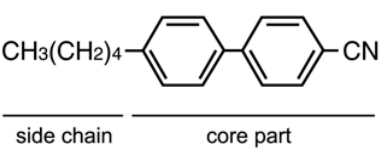
Figure 1. An illustration of the structure of 5CB.